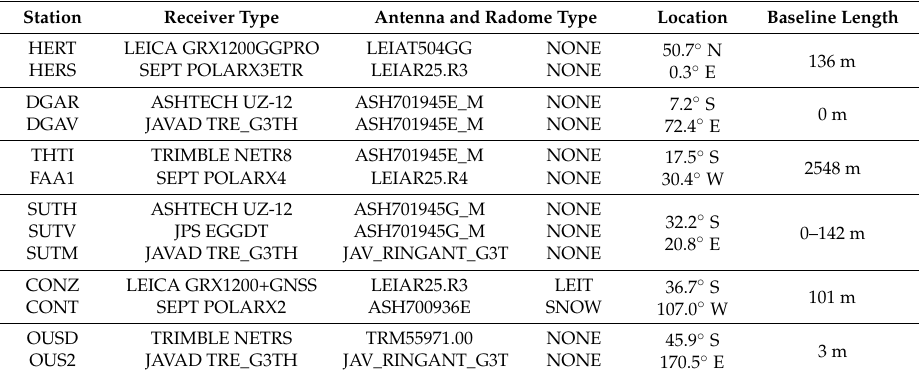
Table 1. An overview of the experimental data sets collected from 13 IGS stations for accuracy assessment of ionospheric observable.